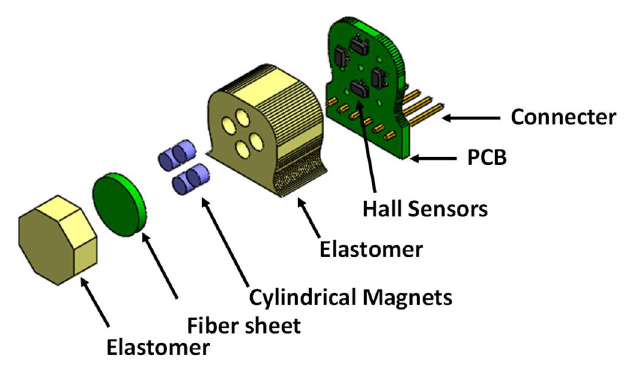
Sensors 2022 , 22 , x FOR PEER REVIEW Figure 2. Exploded view of the proposed magnetic tactile sensor. Figure 2. Exploded view of the proposed magnetic tactile sensor.